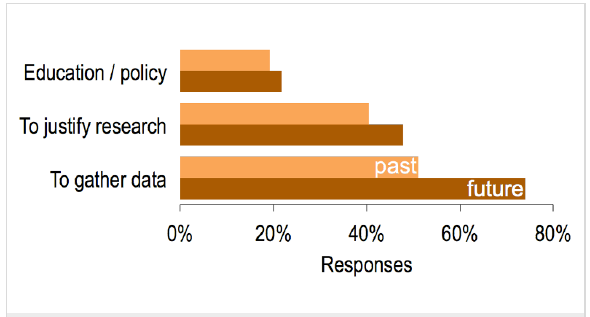
Figure 9: Nanotechnology survey answers on how respondents have used the CPI in the past and how they might use it in the future.